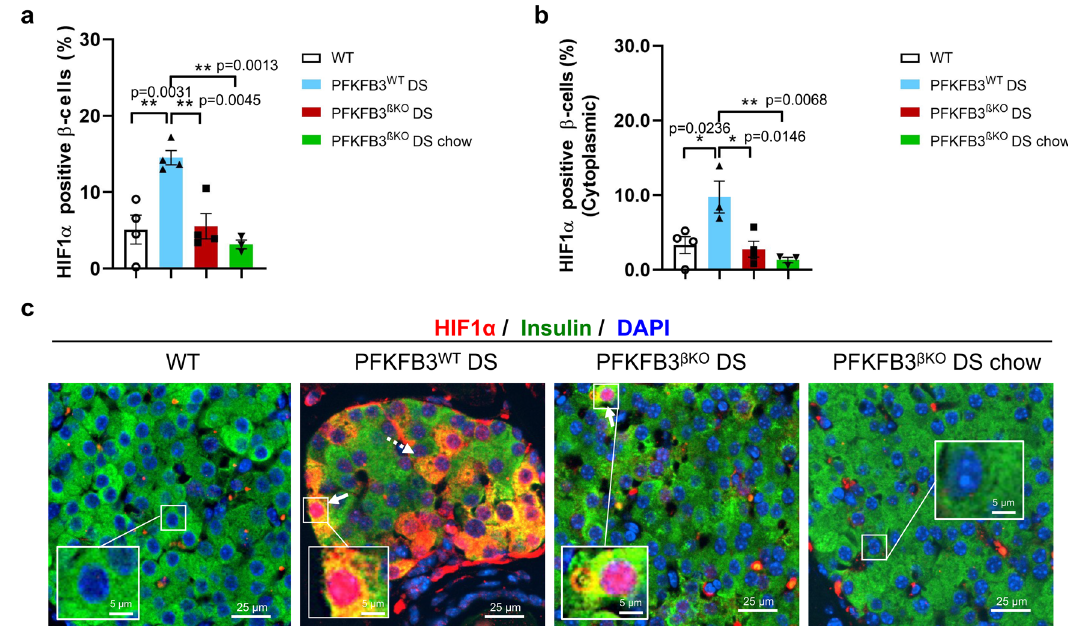
Fig. 4 HIF1 α is downregulated in PFKFB3 β KO DS mice under lower diabetogenic stress. a Quanti fi cation of HIF1 α (total nuclear and cytoplasmic) positive β -cells in the indicated experimental groups (PFKFB3 WT DS relative to WT; PFKFB3 WT DS relative to PFKFB3 β KO DS and relative to PFKFB3 β KO DS chow, n = 4, n = 3 for PFKFB3 β KO DS chow-independent animals, SEM, ** p = 0.0031, ** p = 0.0045 and ** p = 0.0013, respectively). b Quanti fi cation of HIF1 α - (cytoplasmic only) positive β -cells in the indicated experimental groups (PFKFB3 WT DS relative to WT; PFKFB3 WT DS relative to PFKFB3 β KO DS and relative to PFKFB3 β KO DS chow, n = 4, n = 3 for PFKFB3 β KO DS chow-independent animals, SEM, ** p = 0.0236, ** p = 0.0146 and ** p = 0.0068, respectively). c Representative immuno fl uorescence images of islets from WT and PFKFB3 β KO DS mice at 8 weeks of HFD with or without switch to chow diet (PFKFB3 β KO DS chow) immunostained for HIF1 α (red), insulin (green) and nuclei